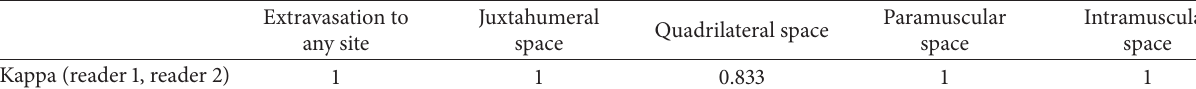
Table 2: To measure the agreement between reader 1 and reader 2 in interpreting extravasation to any site, and to a particular site, kappa statistic was used, with excellent agreement between readers amongst all sites of extravasation. Excellent agreement was defined as Kappa > 0.81 [1].